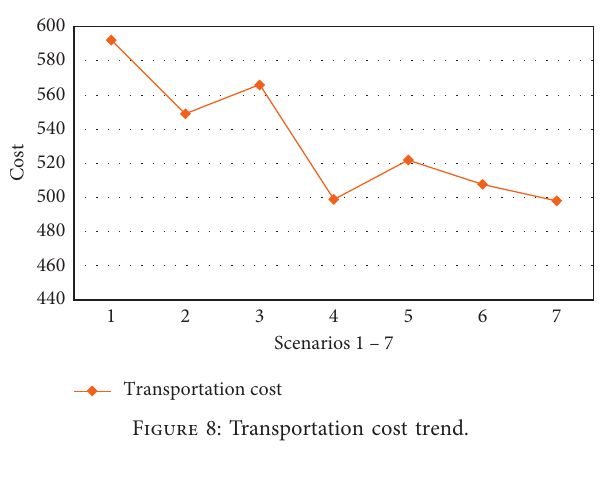
Figure 8: Transportation cost trend.